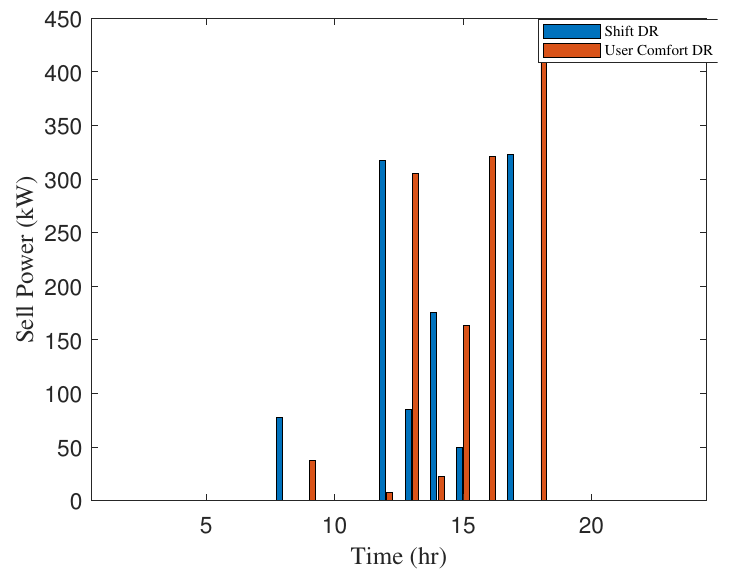
Figure 14. The amount of power sold to the grid.